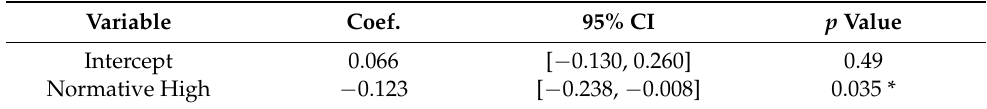
Table 2. Results for the model output from the backwards stepwise feature selection of durations of first looks in the pre-labeling period. Variable Coef. 95% CI p Value Intercept 0.066 [ − 0.130, 0.260] 0.49 Normative High − 0.123 [ − 0.238, − 0.008] 0.035